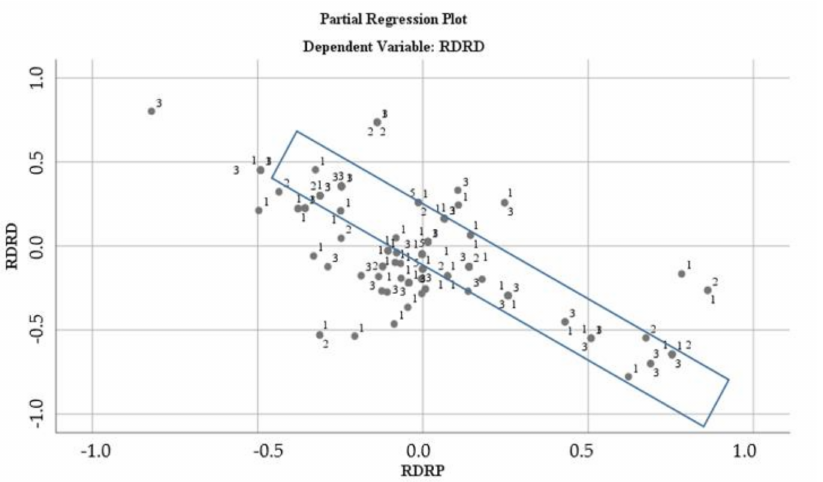
Figure 6. Regression analysis for RDRP.